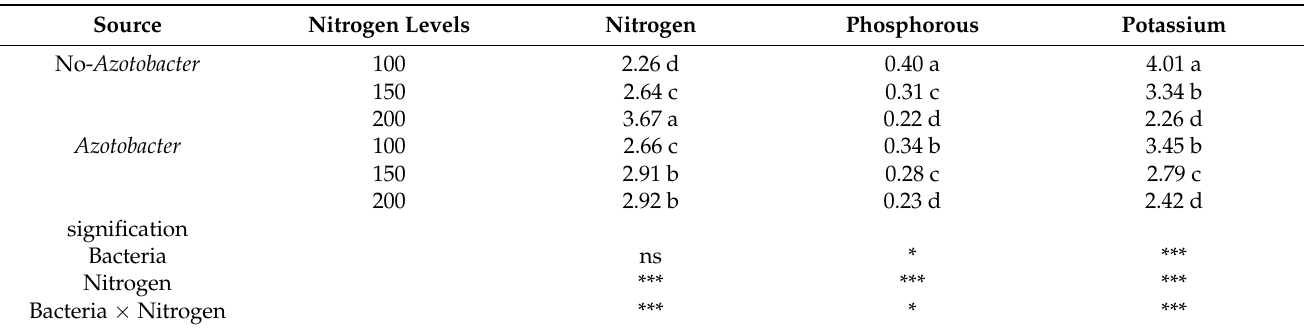
Table 7. Macro nutrient contents (%) in hydroponically grown lettuce influenced by Azotobacter under different nitrogen levels.